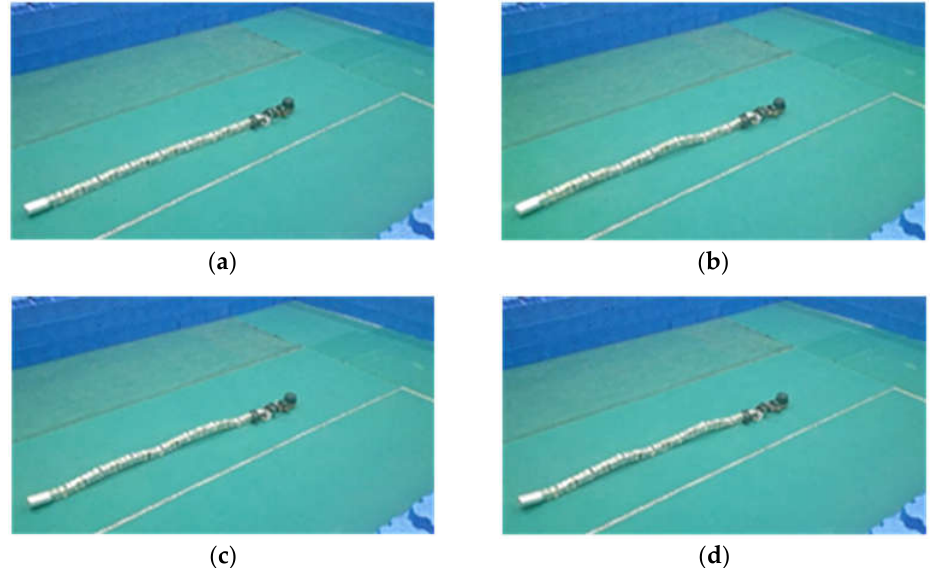
Figure 14. Head stabilization experiment without stabilization algorithm. ( a ) Phase is 0; ( b ) phase is π/2; ( c ) phase is π; ( d ) phase is 3 π/2.